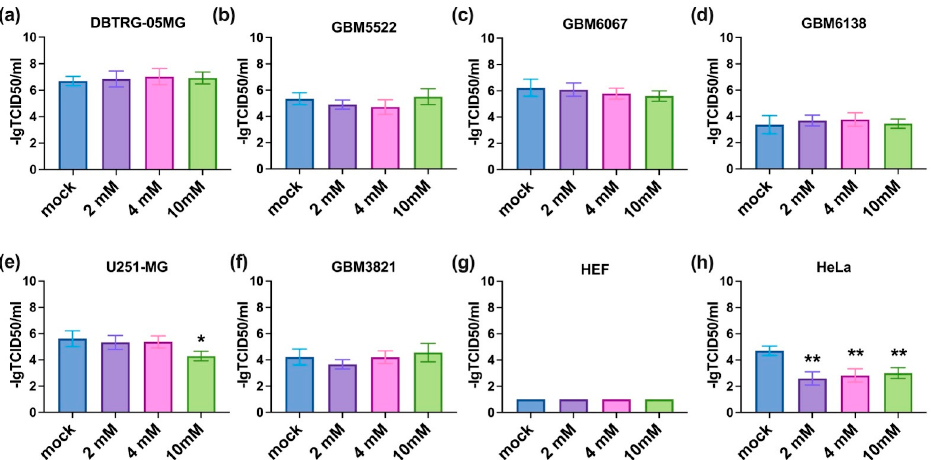
Figure 4. Oncolytic activity of CVB5 towards glioblastoma cells in the presence of metformin decreased in U251-MG ( e ) and HeLa ( h ) but not in DBTRG-05MG ( a ), GBM5522 ( b ), GBM6067 ( c ), GBM6138 ( d ), GBM3821 ( f ) and HEF ( g ) cell lines. Cells were seeded 24 h before treatment with 2, 4, and 10 mM metformin and simultaneous infection with CVB5 at MOIs of 0.001-1000. Viability was determined using CellTracker 48 h later, * p ≤ 0.05, ** p ≤ 0.01.